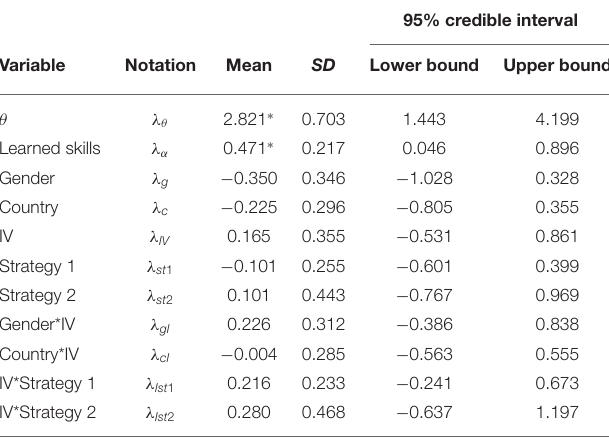
TABLE 7 | The estimated coefficients from the transition model.